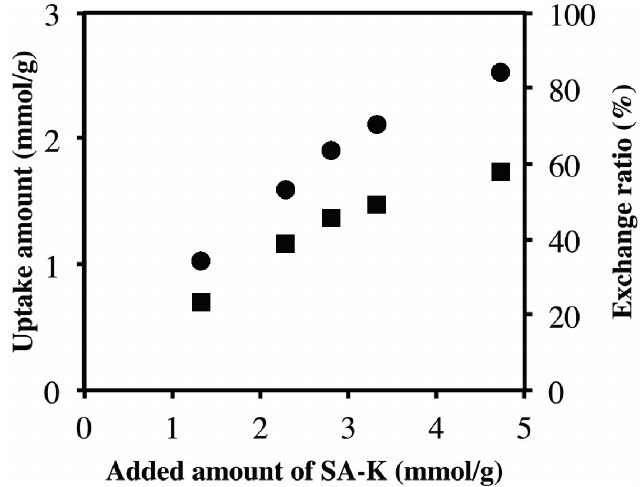
Figure 5. Uptakes ( ● ) and exchange ratios ( ■ ) of sorbate for various amounts of SA-K added.